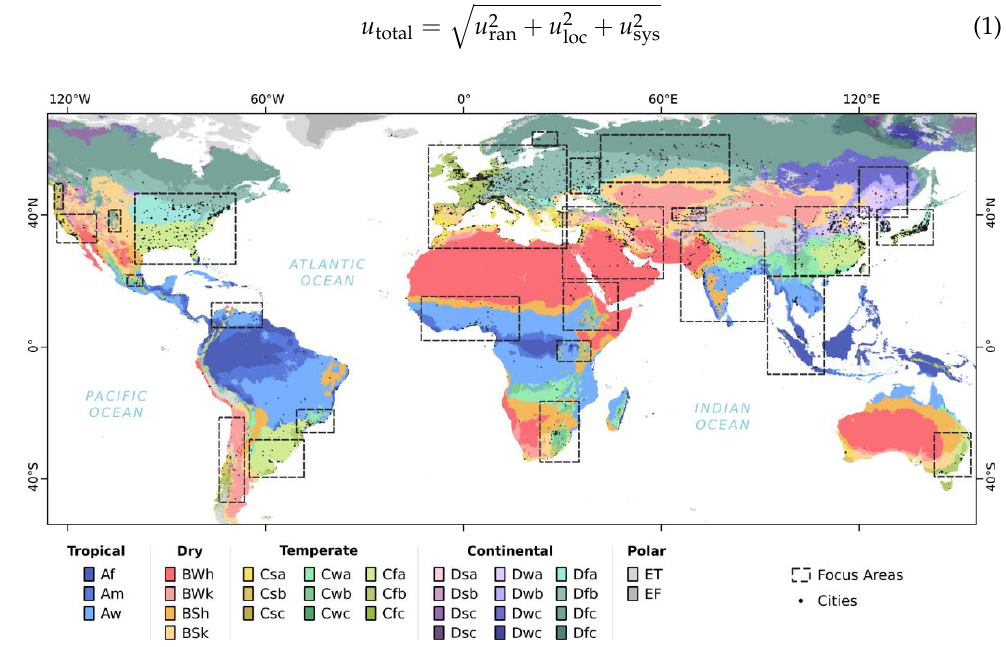
Figure 1. Areas of dense human habitation and the focus areas of this work. The present Köppen – Geiger climate zones are also shown.